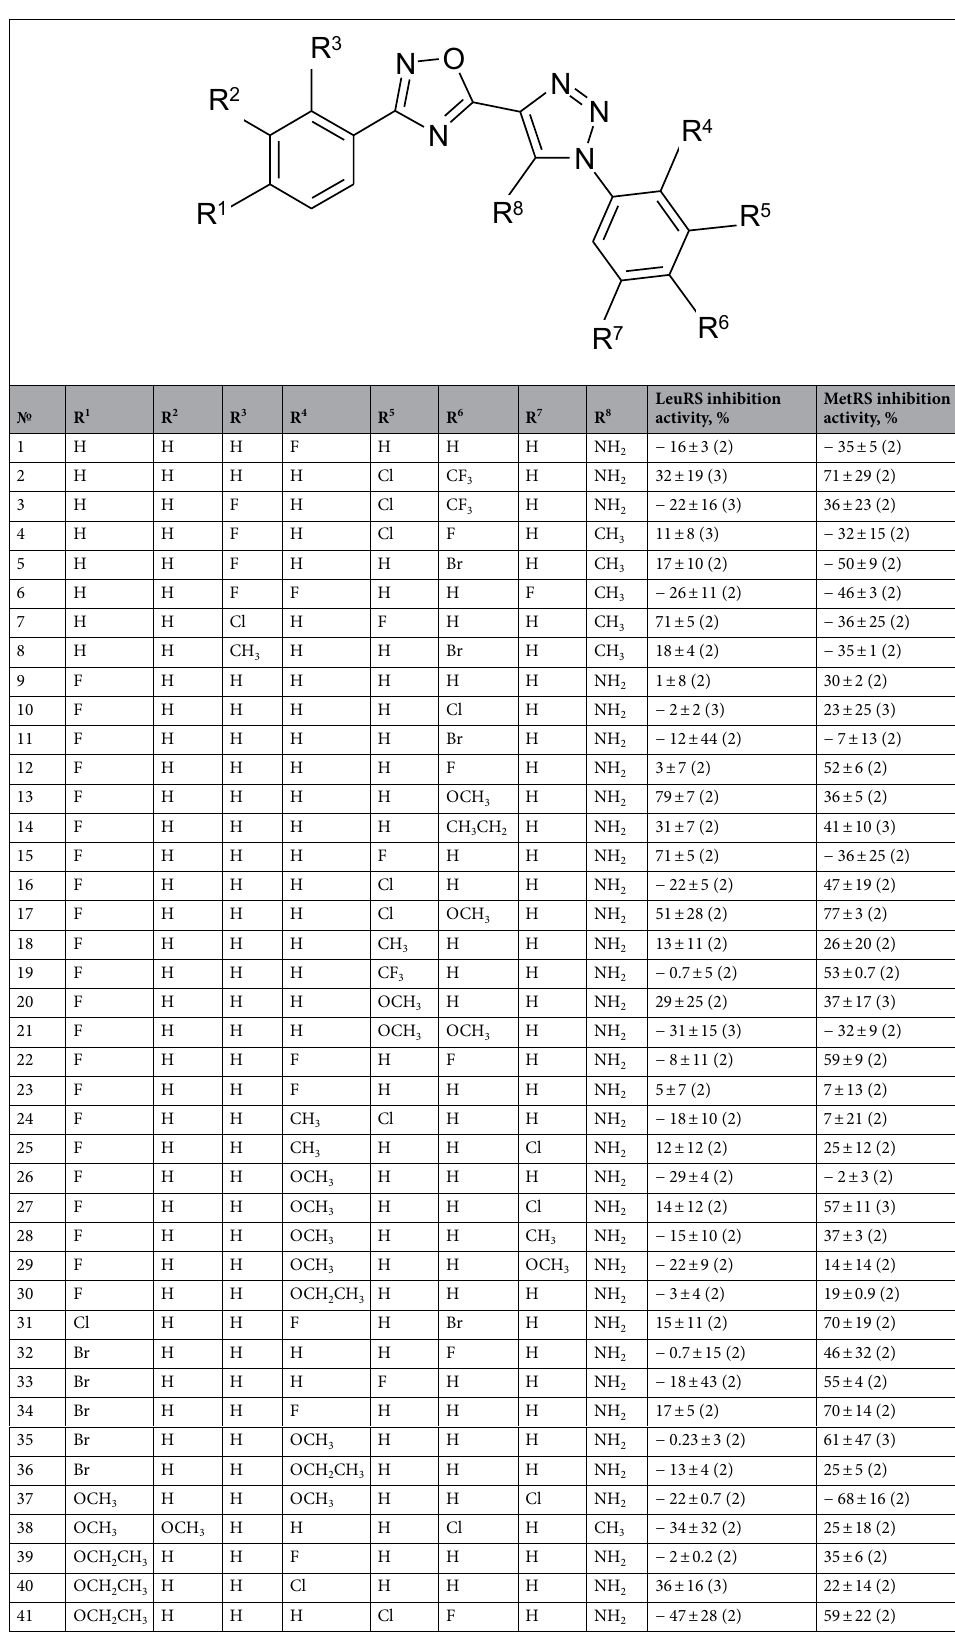
Table 1. Structures and in vitro activity for 3-Phenyl-5-(1-phenyl-1H-[1,2,3]triazol-4-yl)-[1,2,4]oxadiazole derivatives toward M. tuberculosis leucyl-tRNA synthetase (LeuRS) and methionyl-tRNA synthetase